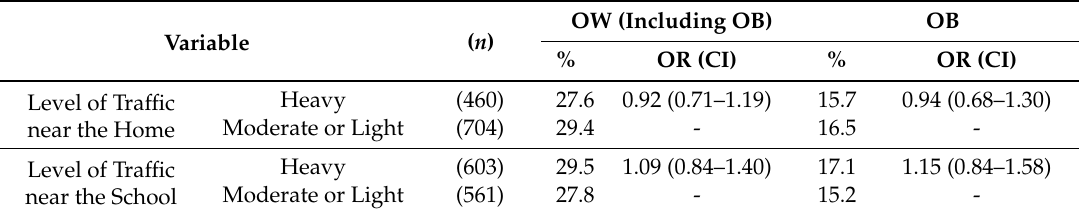
Table 3. Level of traffic perceived by parents near the home and the children’s school in the MAPEC_LIFE cohort.